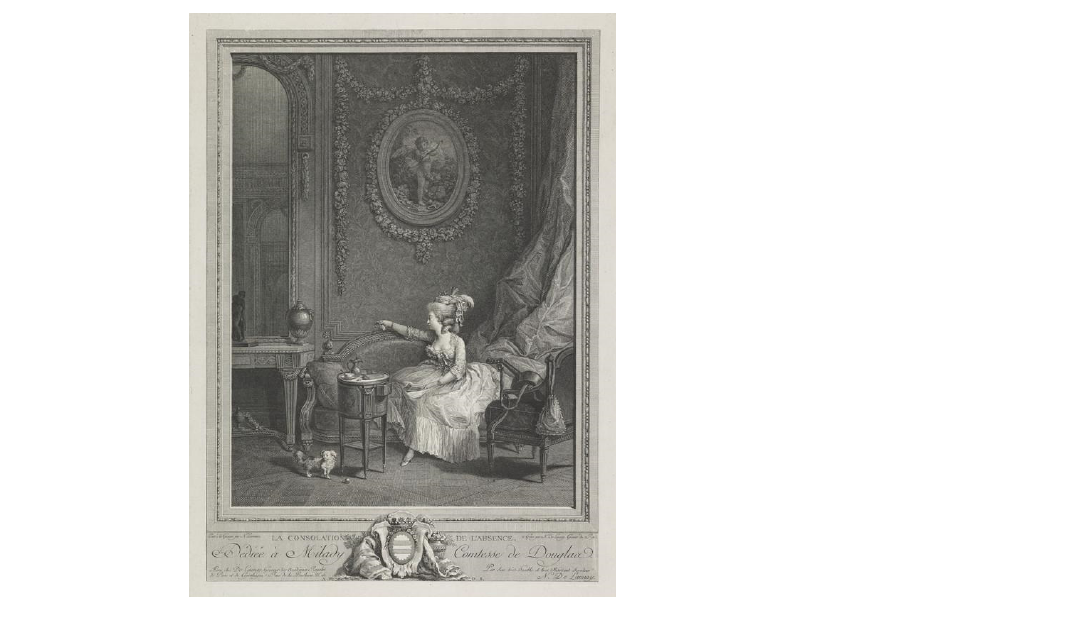
Figure 19. Nicolas Delaunay, after Nicolas Lavreince (Sweden, 1737–1807), La Consolation de l‘Ab- sence , 1785 ca.,Etching and engraving, 35 cm × 24.7 cm, National Gallery of Art, Washington D.C.